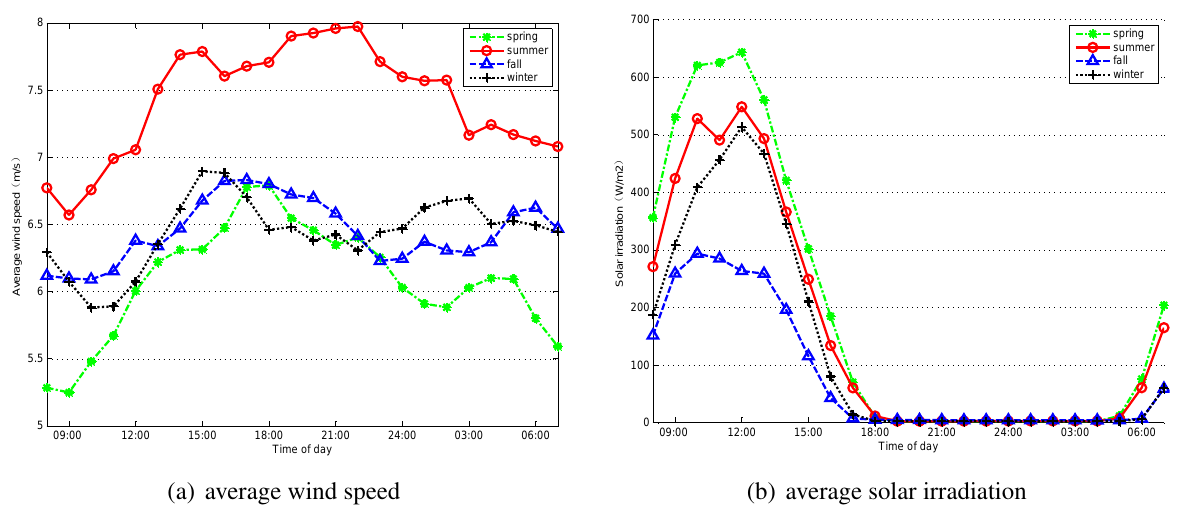
Figure 3. Hourly seasonal mean solar irradiation and wind speed distribution in